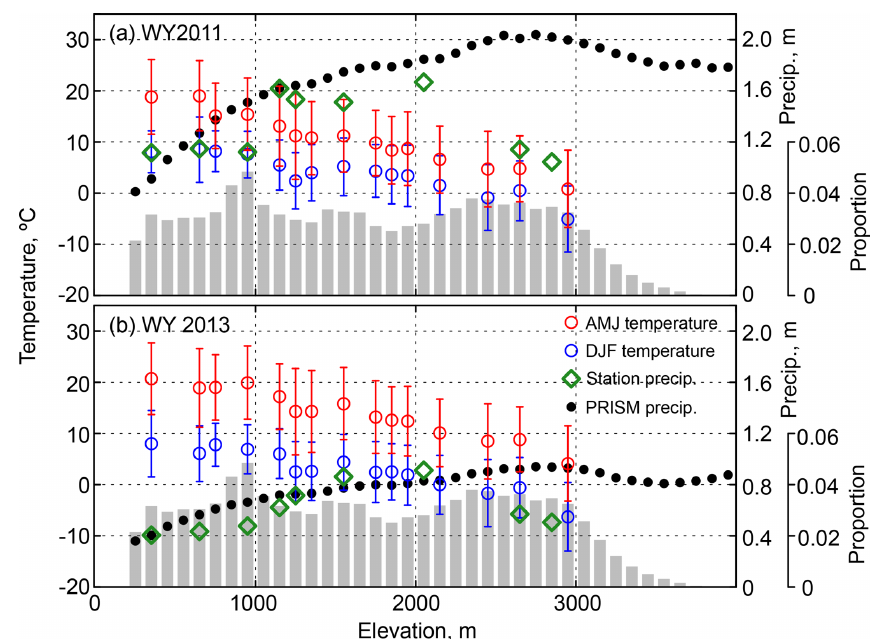
Figure 2. Elevation transects of temperature and precipitation in (a) wet and cold water year 2011, and (b) dry and warm 2013. Temperatures are 3-month means and standard deviations during the main snowpack accumulation period (December–February) and the main snowmelt season (April–June). Precipitation and temperature station data were averaged by 100m elevation band. The shaded area is the proportional basin area in each 100m elevation